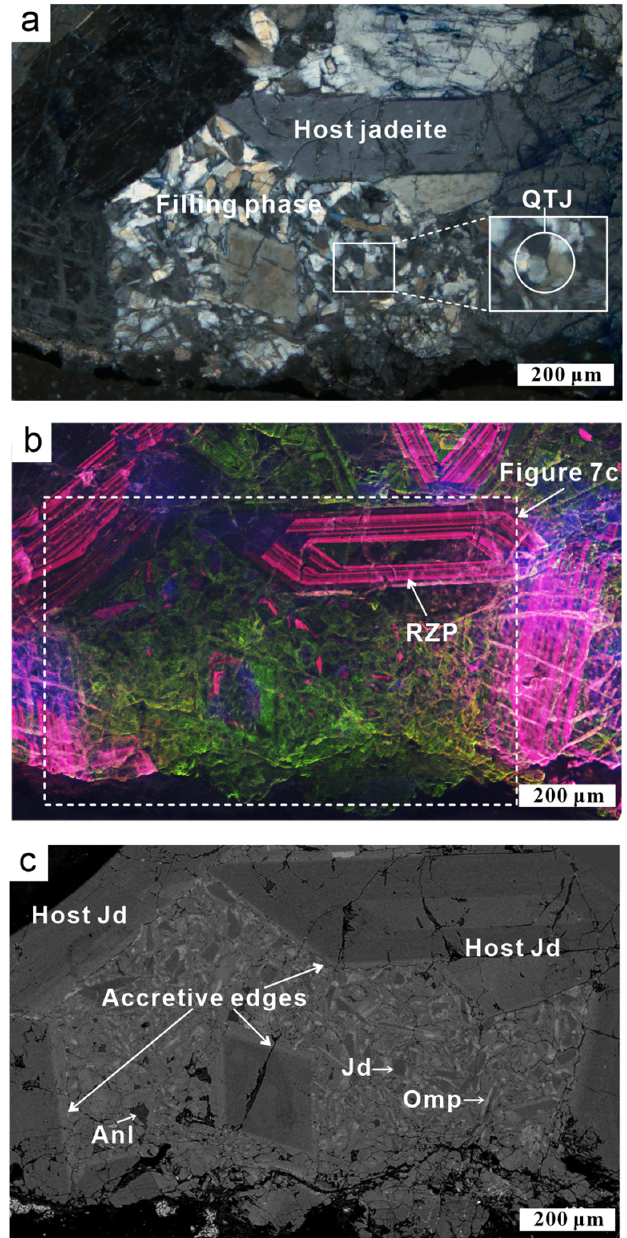
Figure 7. ( a ) In Type I MTDs, the interspace is filled with subhedral jadeite grains, showing high degree of compactness. ( b ) Cathodoluminescence picture of ( a ), the rhythmic zoning patterns (RZPs) visible in the coarser grains. ( c ) BSE image of ( a ) shows clearly overgrowths on the outlines of coarser grains and the relationship between the filling jadeite, omphacite, and analcime in Type I interstitial textures (Jd—Jadeite, Omp—Omphacite, and Anl—Analcime). Type II MTDs contains jadeite (~30 vol.%), omphacite (~40 vol.%), and analcime (~30